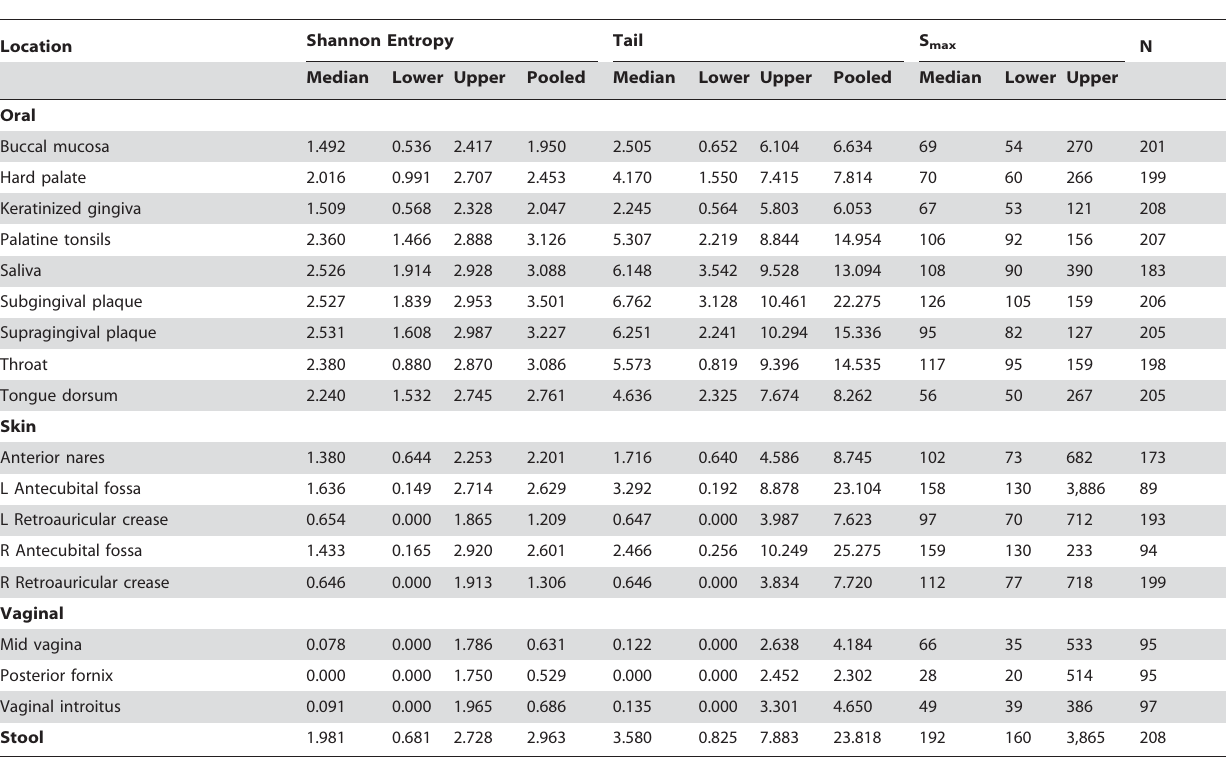
Table 6. Diversity indices computed on ‘‘common’’ OTU-based taxonomic